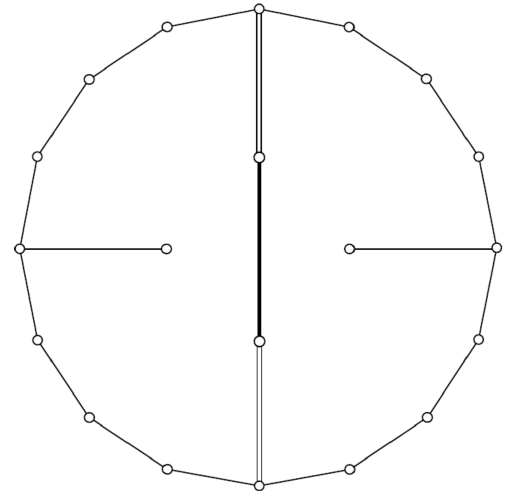
Figure 6. Vinberg’s hyperbolic lattice Γ (cid:48)